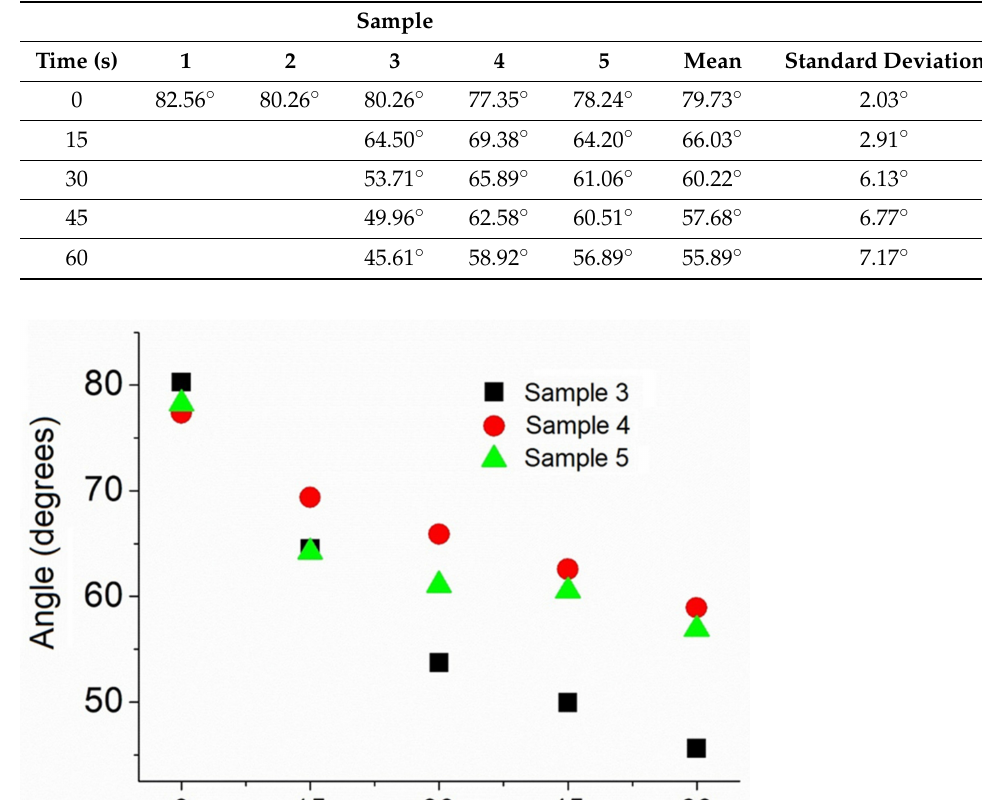
Figure 4. Three-dimensional morphology of sample roughness, obtained by interferometry, display- ing a favorable roughness. ( A , B ) The side that is in contact with mucosa; ( C , D ) the opposite side. Table 2. Contact angle of a NaCl drop with the membrane as a function of time after drop deposition.